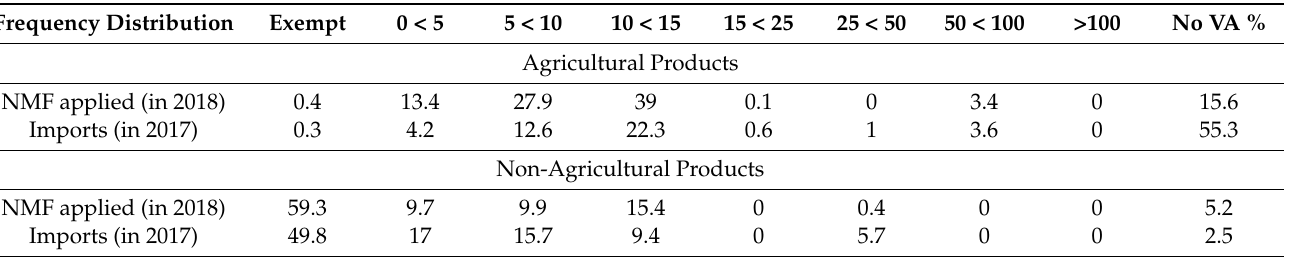
Table 1. Sectoral Tariffs and